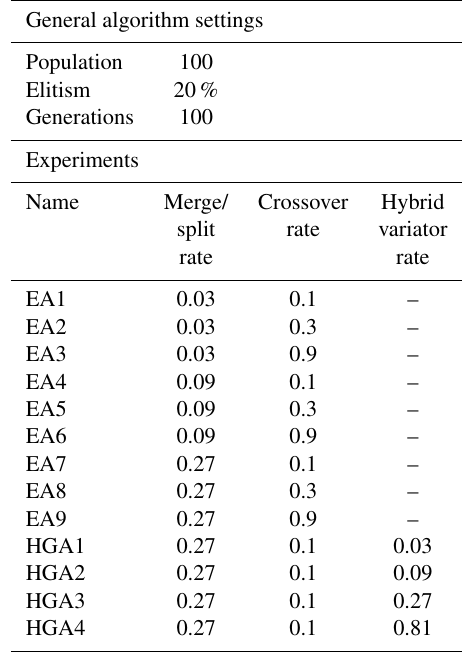
Table 2. Algorithm settings during the experiments